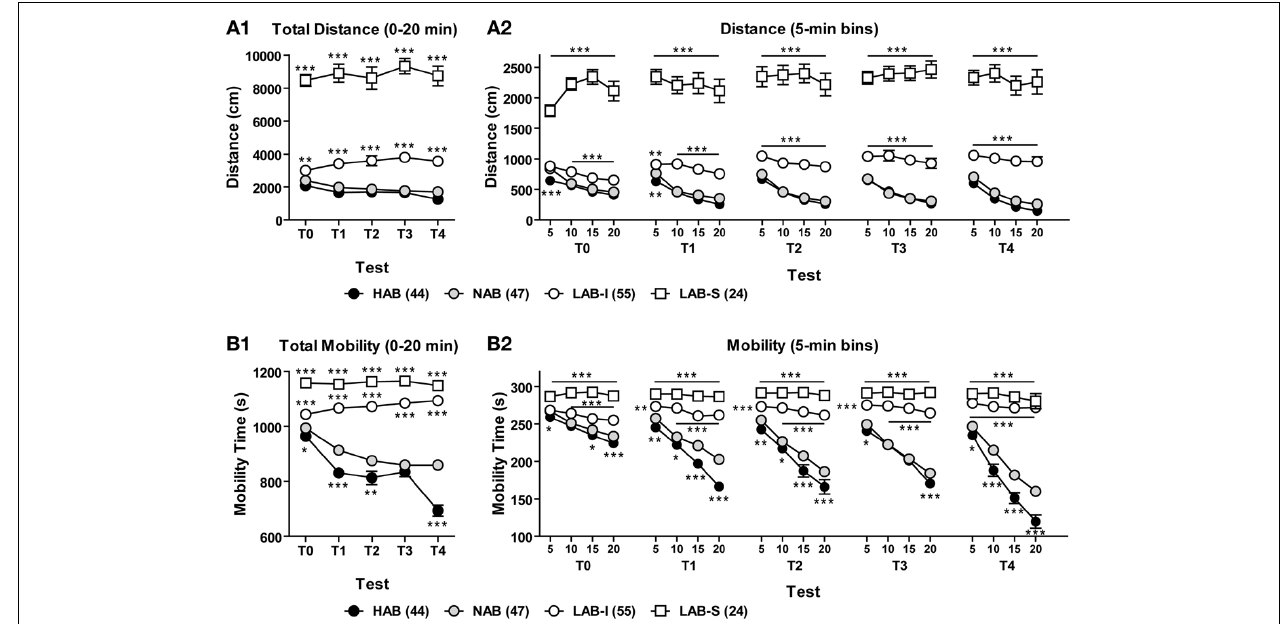
each test and displayed more reduction in distance traveled and mobility time after repeated testing. LAB-I mice showed short-term habituation during the first test (T0), but failed to display short-term habituation after repeated testing. LAB-S revealed no short-term habituation at all as reflected by persistent high levels of distance traveled and mobility time. Mean ± SEM. ∗ p < 0 . 05, ∗∗ p < 0 . 01, ∗∗∗ p < 0 . 001 compared to NAB mice; “line and asterisk” refer to all symbols above/below (Two-Way ANOVA followed by post-hoc Newman–Keuls test).